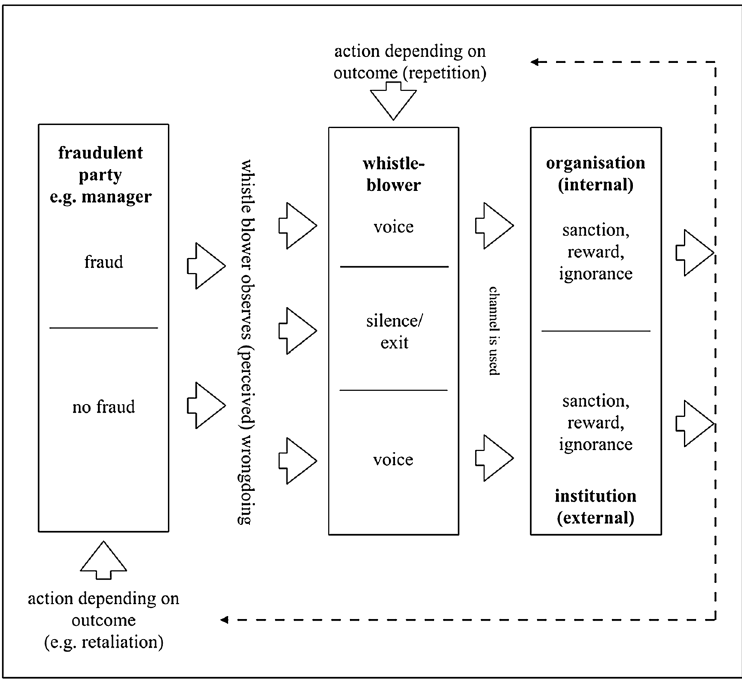
Fig. 1 Whistleblowing process where the potential whistleblower observes fraud and can choose between voice, silence, and exit, which evokes reactions by other internal or external parties of rewards, sanctions, or